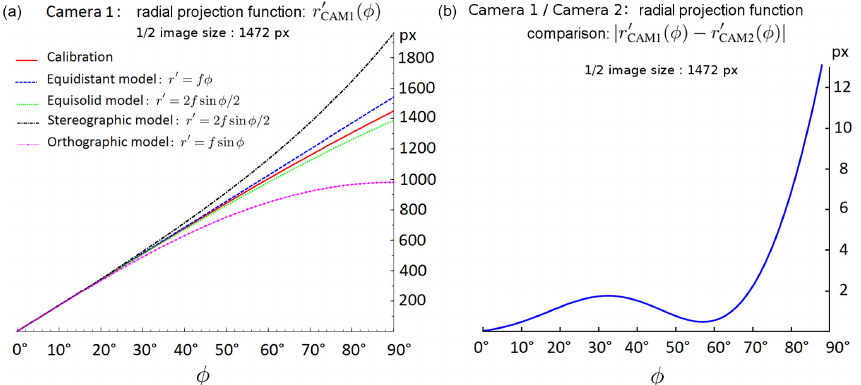
Figure 7. (a) Radial projected distance r (cid:48) as a function of incident angle φ for VIVOTEK camera 1. Function r (cid:48) (φ) is called representation function as it characterize the projection. It is compared to the mostly used fisheye parametric representation functions set with − a 0 value for f . (b) difference in pixels between representation functions of cameras 1 and 2, as a function of incidence angle φ .